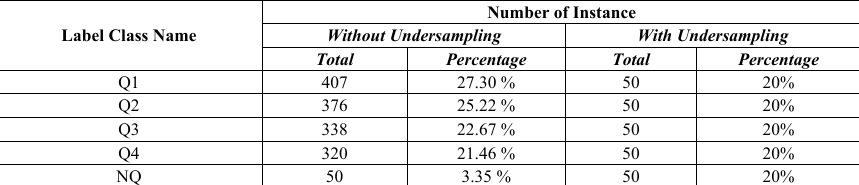
Table 4. Implementation of the undersampling technique on the proportion of label